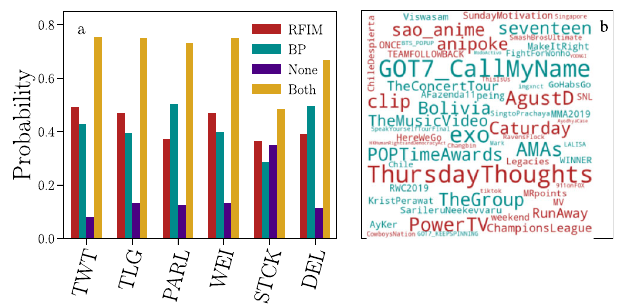
Fig. 4 Simple vs. complex contagion in online social media. a We consider avalanches with size S ≥ S min = 10 and fi t them against the branching process (BP) and the Random Field Ising Model (RFIM). For each time series, we establish whether the fi ts against the individual models are statistically signi fi cant or not; if both fi ts cannot be rejected, we then select the best model by means of the log-likelihood ratio. We report the fraction of time series that are classi fi ed in the RFIM class. This fact may happen because the RFIM fi t cannot be rejected whereas the BP is rejected, or both fi ts cannot be rejected but the RFIM is favored over the BP in terms of log- likelihood ratio. The fraction of time series that are classi fi ed as BP is de fi ned in an analogous manner. The fraction of time series that is classi fi ed as neither BP nor RFIM is represented by the bar labeled as “ None. ” Finally, some time series pass both statistical tests. Their fraction is denoted by the label “ Both ” in the fi gure. In this case, the log-likelihood ratio test is required for model selection, see Fig. 3c. b We restrict our attention to Twitter hashtags containing characters from the English alphabet only, and display the 30 most popular hashtags classi fi ed either in the RFIM (blue) or the BP (red) classes. The font size is proportional to the rank of the hashtag in each class. Hashtags of both classes are selected among those that are suf fi ciently critical, i.e., j ^ R (cid:2) R c j = R c (cid:4) 0 : 05 for a time series in the RFIM class or j ^ n (cid:2) n c j = n c (cid:4) 0 : 05 for a time series in the BP